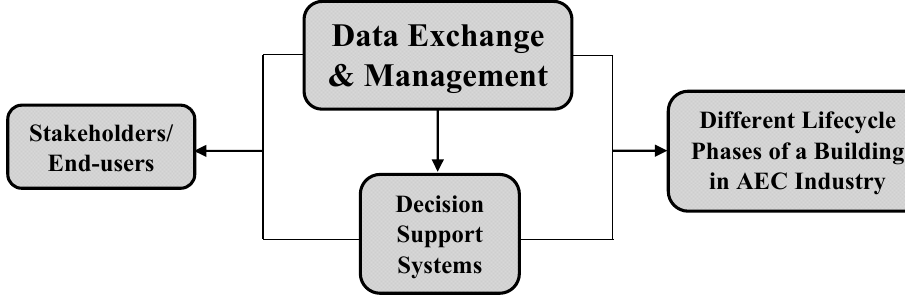
Figure 3. Data exchange and management in buildings.